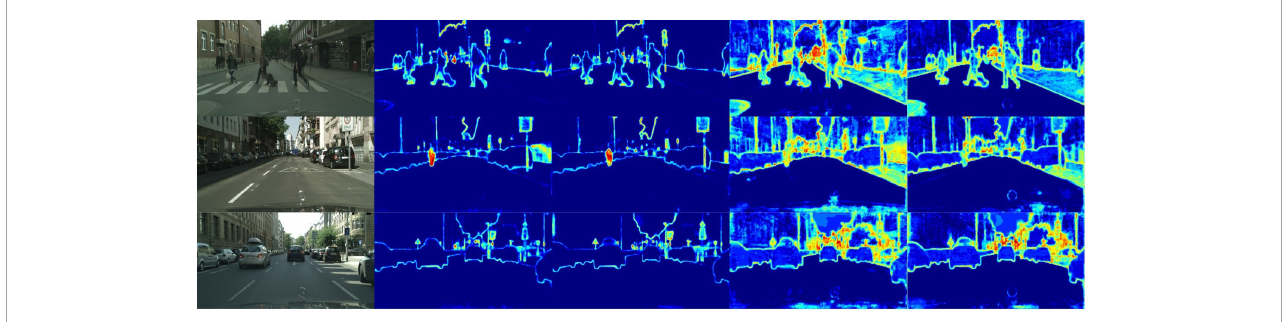
FIGURE4 The lightweight semantic segmentation network (LSNet) feature visualization. The picture from left to right is: the original image, the encoder feature map using DAB, the encoder feature map using 1D-mixer, the network output feature map using DAB, and the network output feature map using